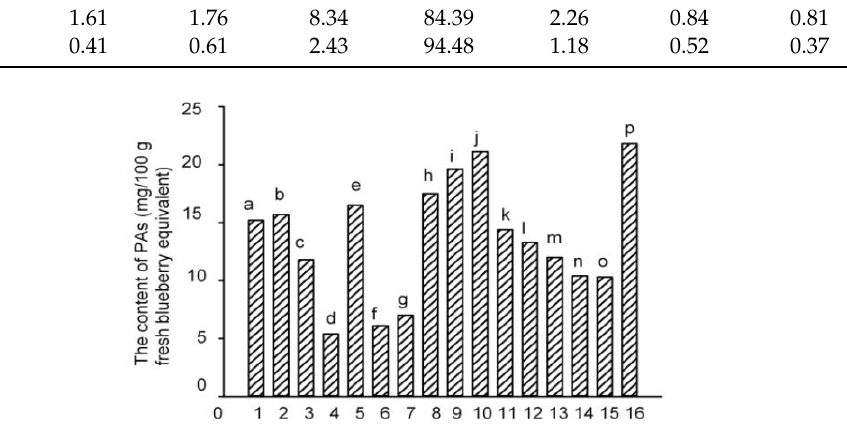
Figure 2. Total PA contents of the 16 blueberry polyphenol fractions. (The results have been expressed in terms of mg/100 g fresh blueberry equivalent, means ± SD, n = 3; columns with the different letters are significantly different, p < 0.05, n = 3).